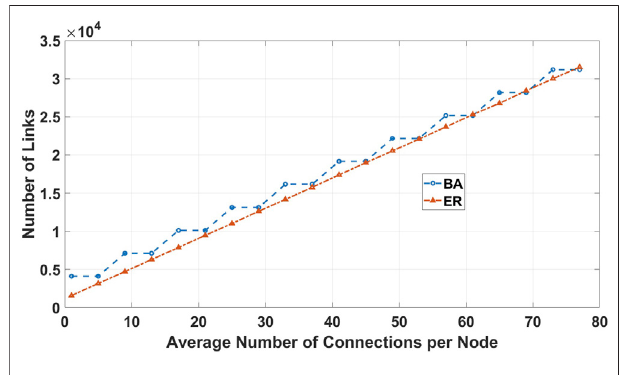
FIGURE 12 | Total number of links (traf fi c overhead) for N=10000